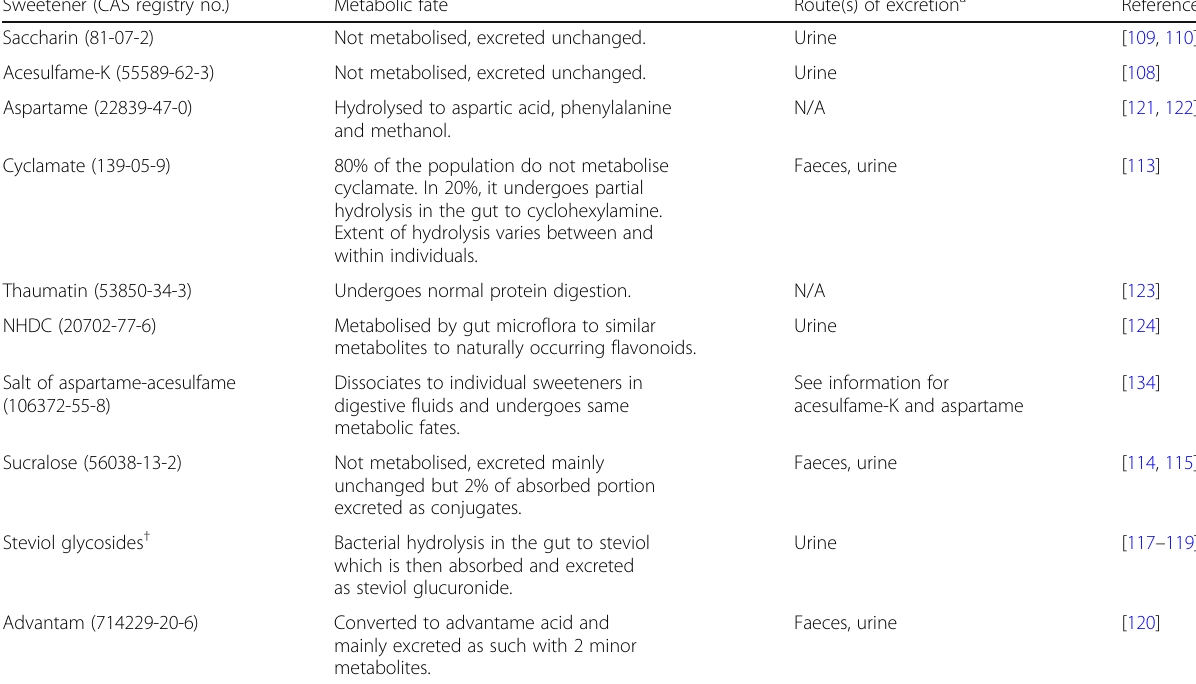
Table 6 Metabolic fates of low-calorie sweeteners approved in the European Union (adapted from [107]) Sweetener (CAS registry